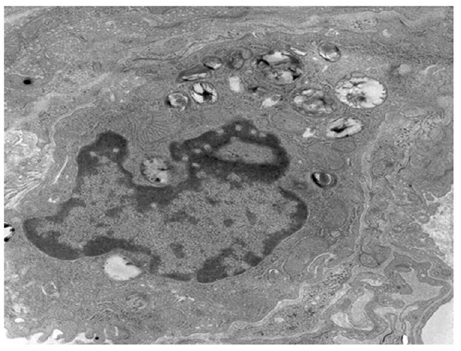
Figure 9. The Type II alveolar epithelial cells in the bosentan group ( 6 8000). The damage was ameliorated to some degree relative to the PQ group. Their nuclei membrane and the endoplasmic reticulum were integral and smooth, the mitochondrial cristae were limpid but still a litter disorder, vacuolation of the lamellar bodies were ameliorated, a few mature lamellar bodies were